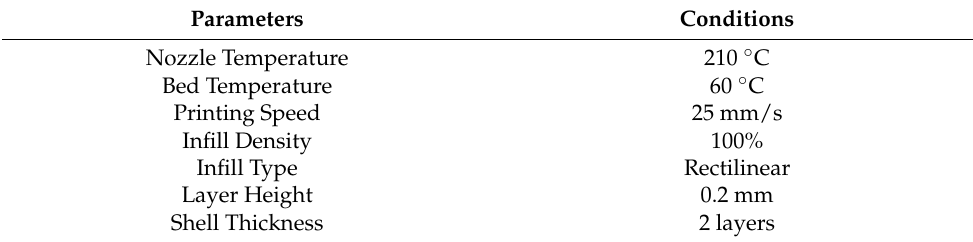
Figure 1. 3D printing specimens: ( a ) horizontal dumbbell; ( b ) horizontal bar; ( c ) vertical dumbbell; ( d ) vertical bar. Table 2. Conditions of FDM 3D